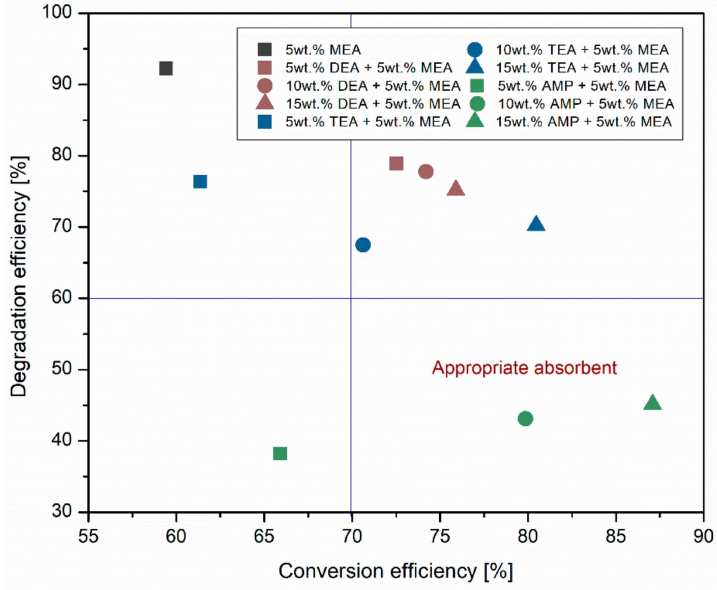
Figure 7. Correlation between conversion and degradation efficiencies in blended alkanolamine absorbents in multicycle integrated absorption–mineralization